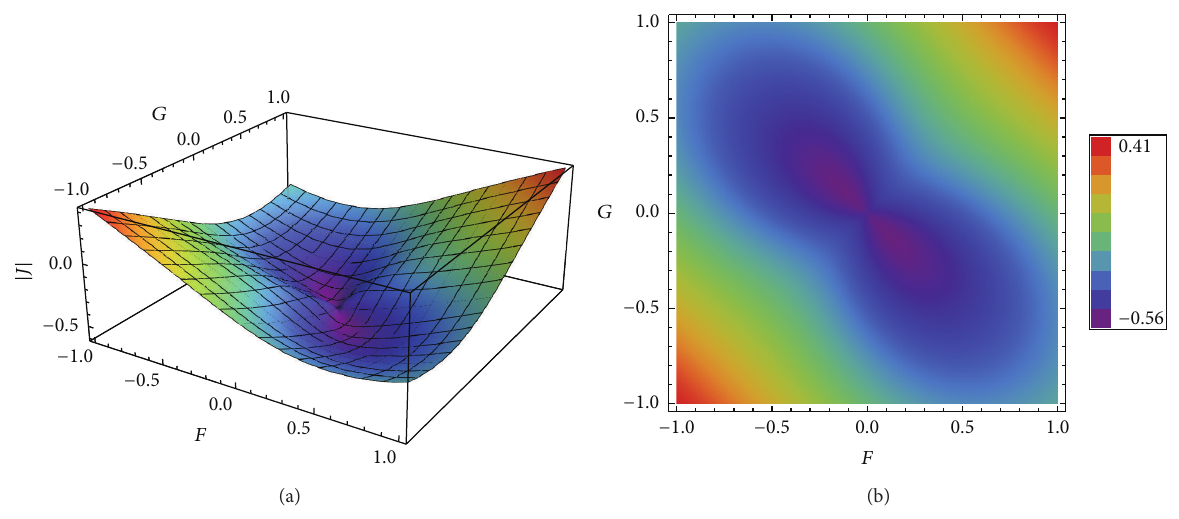
Figure 4: (a) 3D plot and (b) contour plot of det (𝐽 𝐺 )